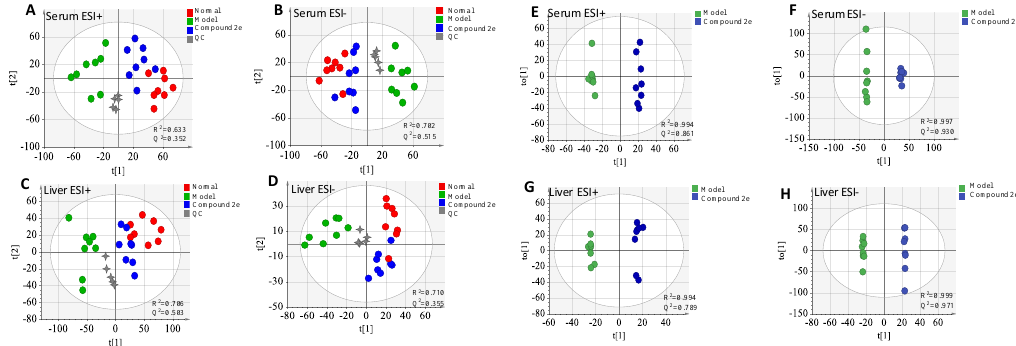
ESI– modes (Figure 6E–H). In the OPLS-DA score plots, each spot also represented a se- rum or a liver sample. Either in serum samples or in liver samples, the model group and compound 2e group were both separated with satisfactory R 2 and Q 2 parameters.